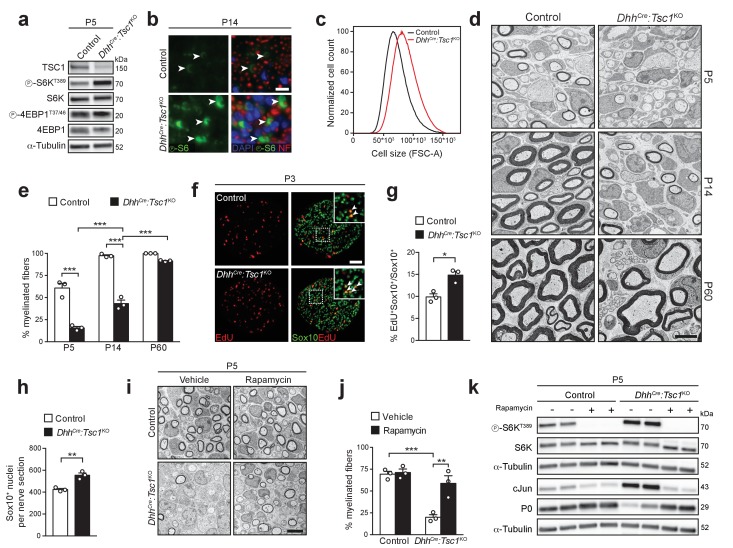
High mTORC1 signaling following TSC1 deletion delays SC myelination.(a) Western blot analysis, sciatic nerve lysates of P5 controls and littermates DhhCre:Tsc1KO (mutant) animals (n = 3 mice/genotype). Quantification: Figure 1—figure supplement 1a. (b) Immunostaining, P14 sciatic nerve cross sections (n = 3 control/4 mutant mice). Arrowheads indicate phospho-S6 positive cells. NF: neurofilament. Nuclei: DAPI. Scale bar: 10 μm, refers to whole panel. (c) Flow-cytometry profile of DRG-derived SCs (n = 4 individual experiments with four independent cell preparations). A representative experiment is shown. FSC-A: Forward Scatter Area. (d) Electron micrographs of sciatic nerve cross sections of controls and littermate mutants at different time points (n = 3 mice/genotype). Scale bar: 4 μm, refers to whole panel. (e) Myelinated fibers relative to all sorted fibers. Bar heights: Mean; error bars: s.e.m. (n = 3 mice/genotype, two-way ANOVA with Tukey’s multiple comparisons test, F(2,12) = 37.09, p<0.0001; pP5 control vs KO <0.0001, pP14 control vs KO <0.0001, pP5 vs P14 KO = 0.0002, pP14 vs P60 KO < 0.0001). At least 150 sorted fibers per sample were counted (random EM fields). (f) EdU-labeling and Sox10 immunostaining on P3 sciatic nerve cross sections (n = 3 mice/genotype). Arrowheads indicate Sox10/EdU double-positive SC nuclei. Scale bar: 50 μm, refers to whole panel. (g,h) Quantifications of f. Sox10/EdU double-positive of Sox10-positive nuclei (g), Sox10-positive nuclei per sciatic nerve cross section (h). Bar heights: Mean; error bars: s.e.m. (n = 3 mice/genotype; two-tailed unpaired Student’s t-test; g, t(4) = 4.407, p=0.0116; h, t(4) = 5.77, p=0.0045). (i) Electron micrographs of P5 sciatic nerves from control and mutants treated with vehicle or rapamycin. Scale bar: 4 μm, refers to whole panel. (j) Quantification of i. Myelinated fibers relative to all sorted fibers. At least 150 sorted fibers per sample were counted (random EM fields). Bar heights: Mean; error bars: s.e.m. (n = 3 mice/condition, two-way ANOVA with Tukey’s multiple comparisons test, F(1,8) = 12.22, p=0.0081; pcontrol vs KO vehicle = 0.0008, pKO vehicle vs rapamycin = 0.0037). (k) Western blot analysis, P5 sciatic nerve lysates from controls and mutants treated with vehicle or rapamycin (n = 4 mice/condition). Quantification: Figure 1—figure supplement 1b. *p<0.05, **p<0.01, ***p<0.001.